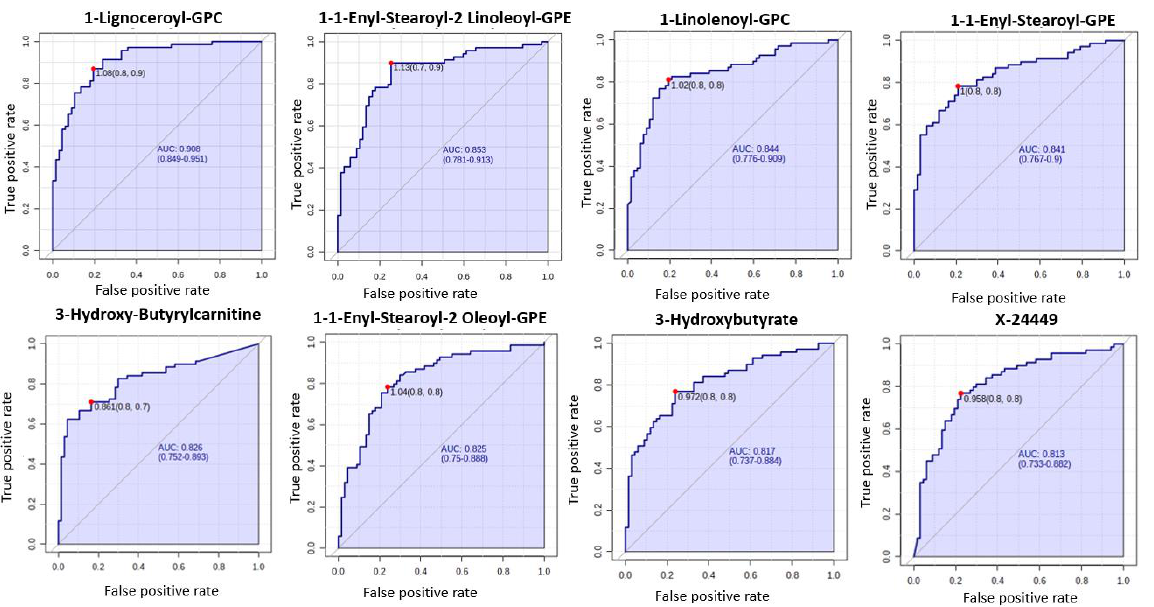
Figure 1. Receiver operating characteristic (ROC) curves of the promising endometrial cancer diagnostic biomarkers from different classes based on the area under the curve (AUC) analyses of n = 67 cancers and n = 69 controls. The optimal cut-off was based on the closest to the top left corner principle and is indicated by the red dot in the ROC curves. Metabolites starting with X are unnamed; the pathways of these are unknown. GPC—Glycerophosphocholine. GPE— Glycerophosphoethanolamine.